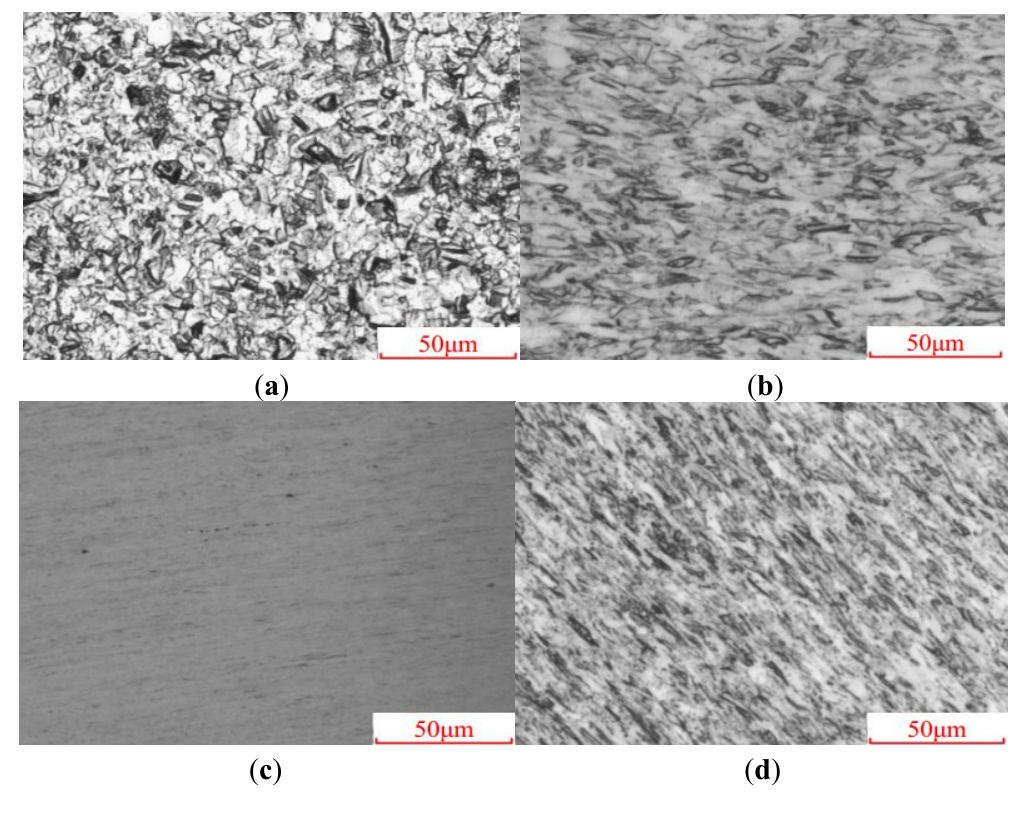
Figure 2. OM (Optical Micrographs) of Cu-0.2wt%Mg alloy ( a ) in Conform state and after ECAP at 473 K for ( b ) 1 pass, ( c ) 4 passes and ( d ) 16